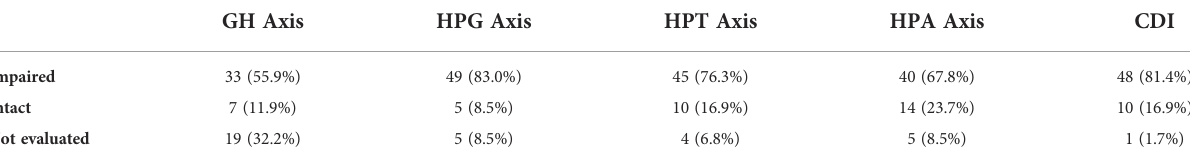
TABLE 2 Hypothalamic-pituitary endocrine dysfunction of adults with hypothalamic dysfunction (n=59).